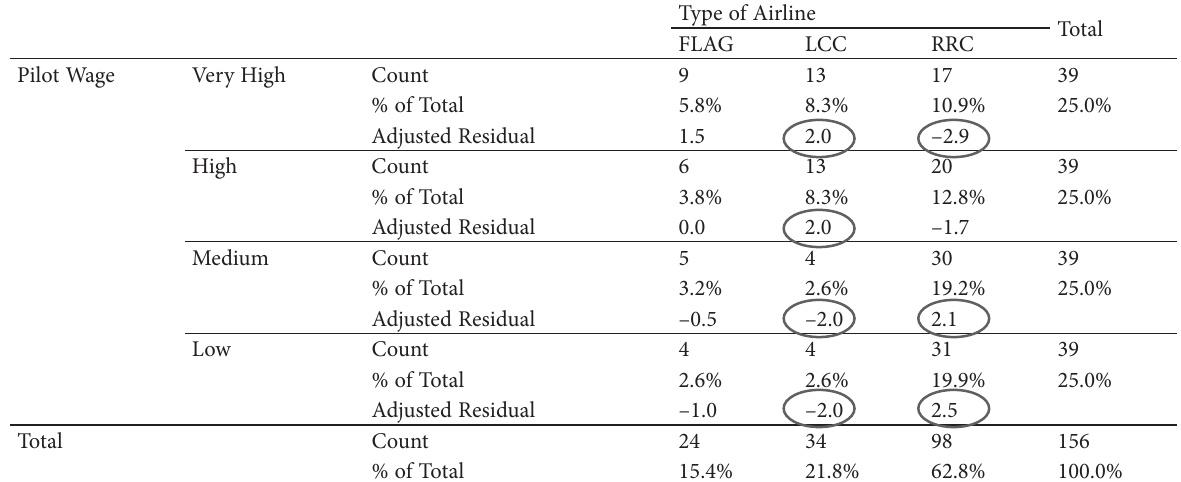
Table 9. First Officer Base 2008. Cross tabs adjusted and standardised by